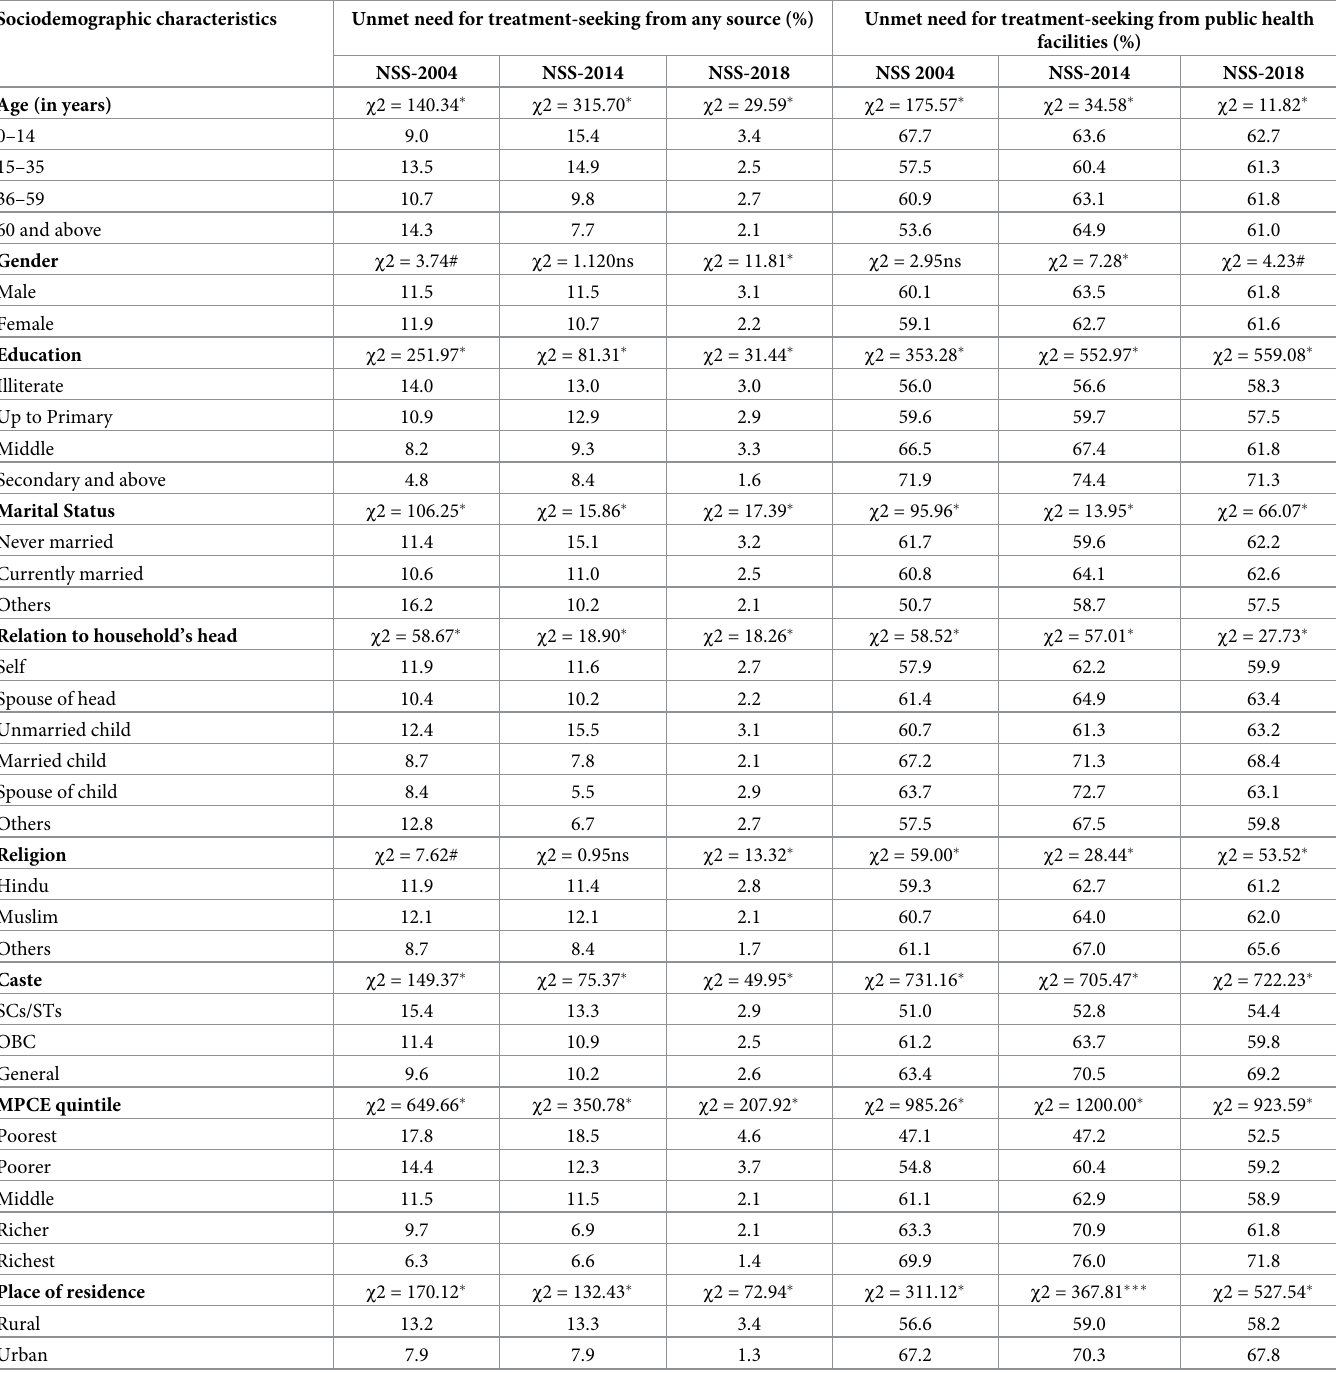
Table 2. Unmet need for treatment-seeking and unmet need for treatment-seeking from public health facilities among those who suffered/are suffering from any disease by Sociodemographic characteristics in India, NSS, 2004–2018. Sociodemographic